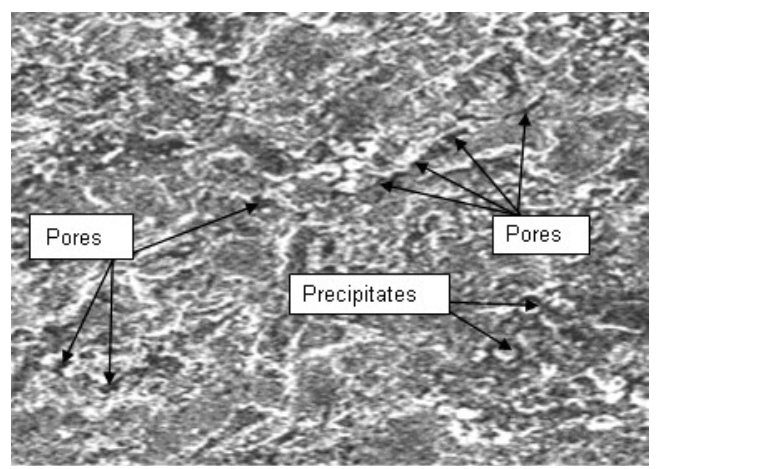
Figure 5 – SEM surface morphology of the Ni20Al coating deposited with a (PS) distance of 80 mm